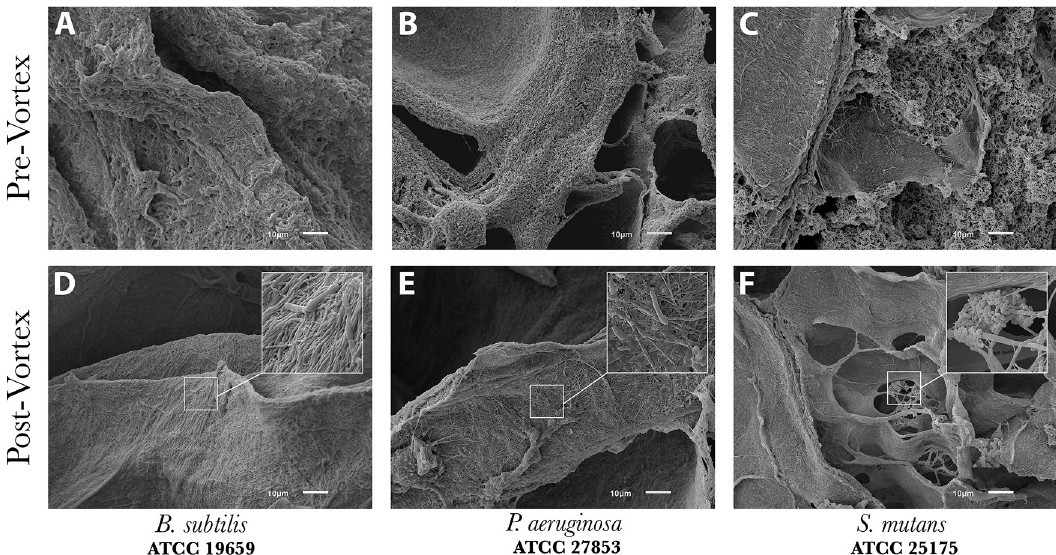
Fig 6. Representative SEM images of collagen coupons with three isolates pre- and post-vortex/sonication to demonstrate the ability of the process to remove bioburden from material surfaces. (A-C) Representative images of biofilm structures prior to vortex and sonication. (D-F) Images of residual cells on collagen after vortex and sonication. Data indicated that biofilms were effectively disrupted/removed with < 5% of cells remaining on the surface.